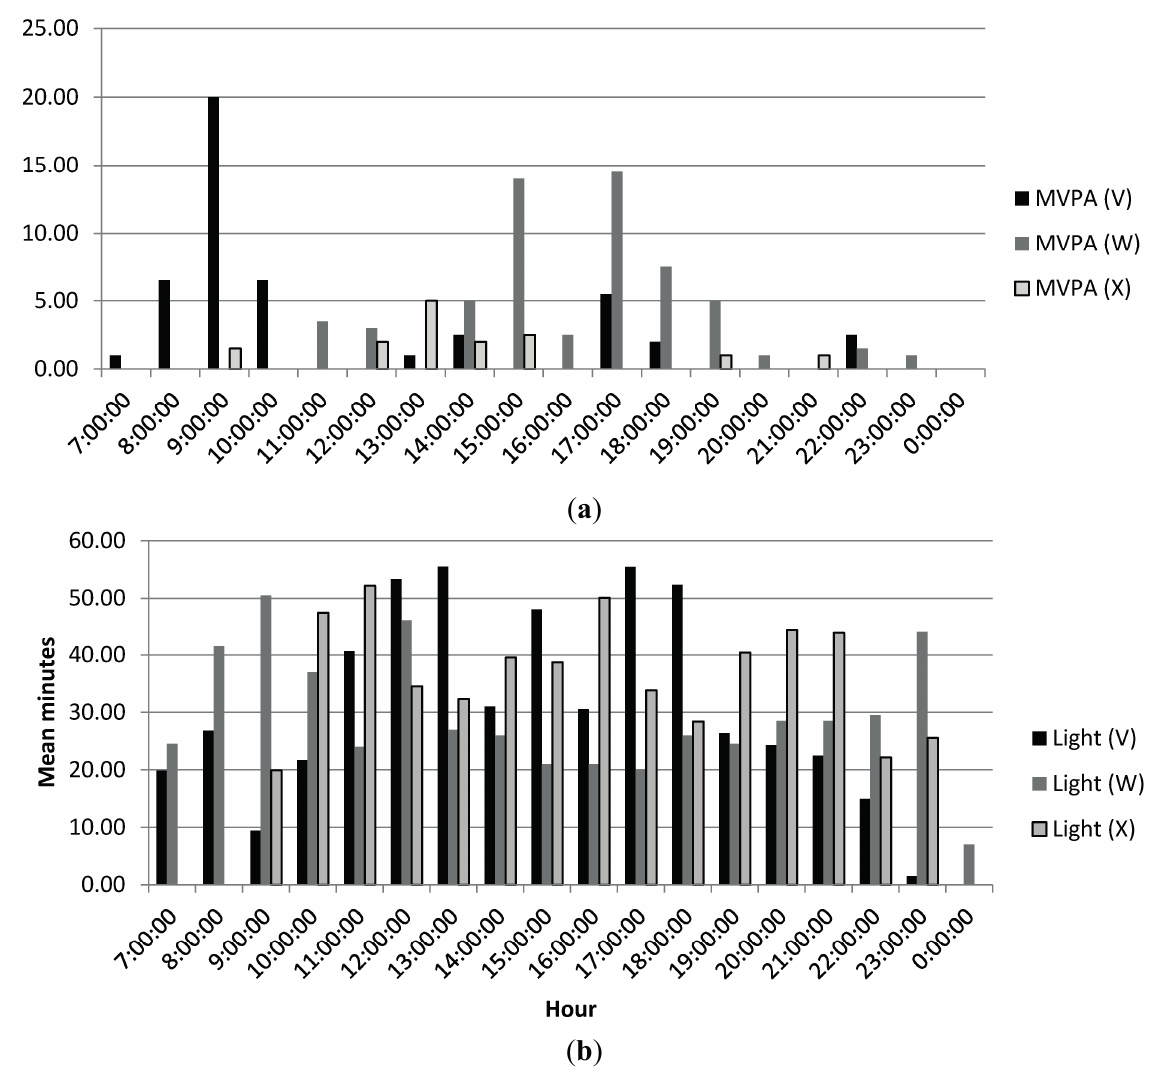
Figure 3. ( a ) Mean daily MVPA for group exercisers; ( b ) Mean daily light intensity PA for group